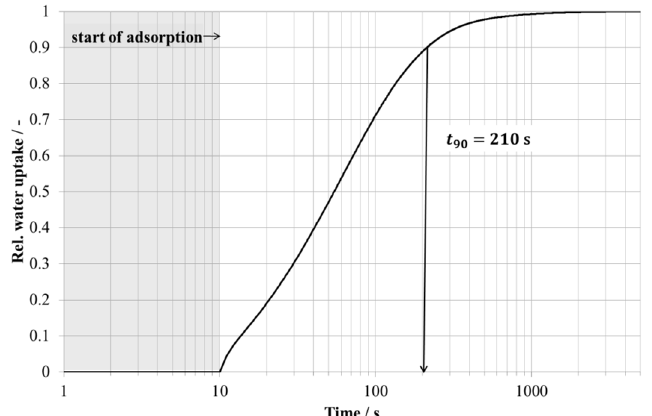
Figure 3. Water uptake (relative to final uptake) over time at 38.7 °C for small sample at a start loading of 0.06 g H2O /g Ade .